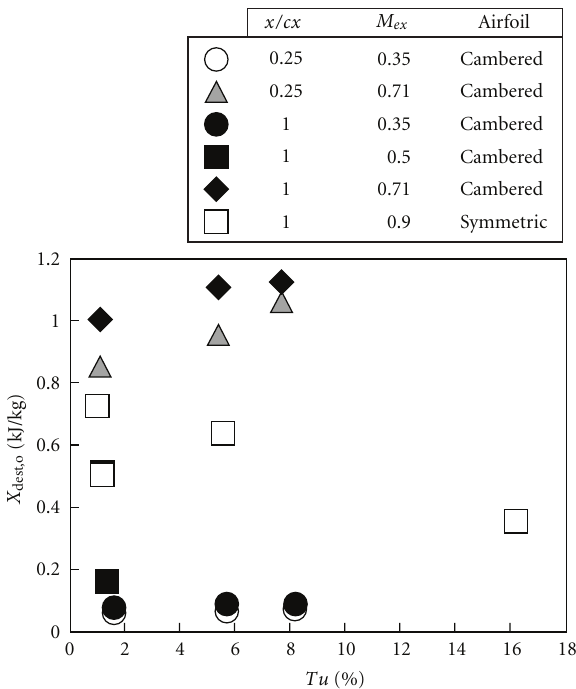
Figure 27: Overall exergy destruction as it varies with surface freestream turbulence intensity for di ff erent measurement locations downstream of di ff erent smooth airfoils with di ff erent exit Mach numbers.